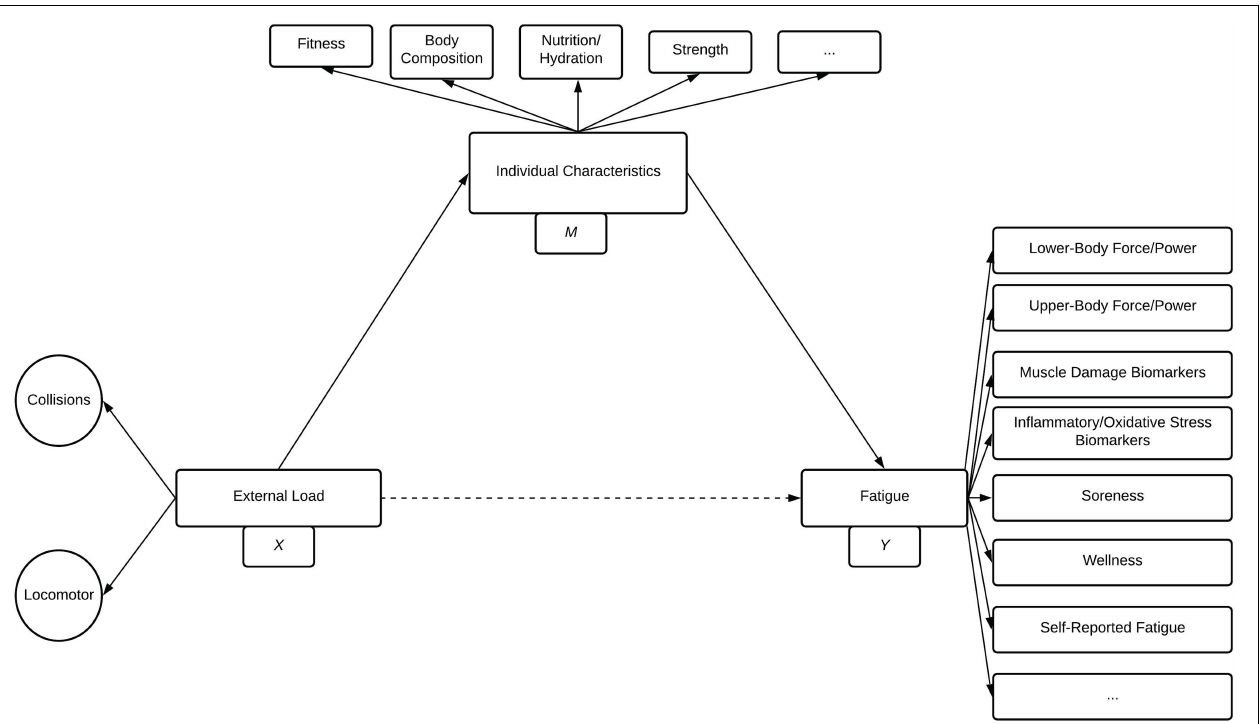
FIGURE 4 | A mediation path model representing the hypothesis that individual characteristics ( M ) mediate the effect of external load variables ( X ) on fatigue variables ( Y ). This mediation model describes external load, individual characteristics, and fatigue as latent variables and includes examples of functional measures which contribute to individual characteristics and fatigue. Single-headed arrows indicate an assumed causal relationship, and dashed arrows indicate the effect may be mediated. Ellipses represent other factors which may contribute but which are not included in the model.